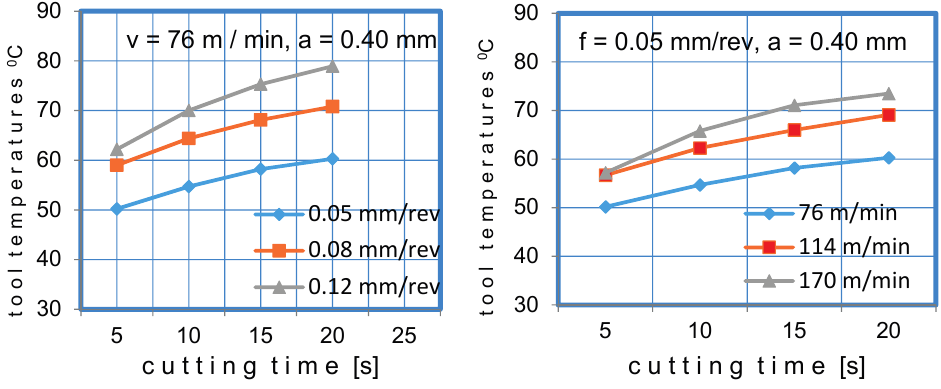
Figure 10. Change of tool temperature during the cutting process, depending on the time.